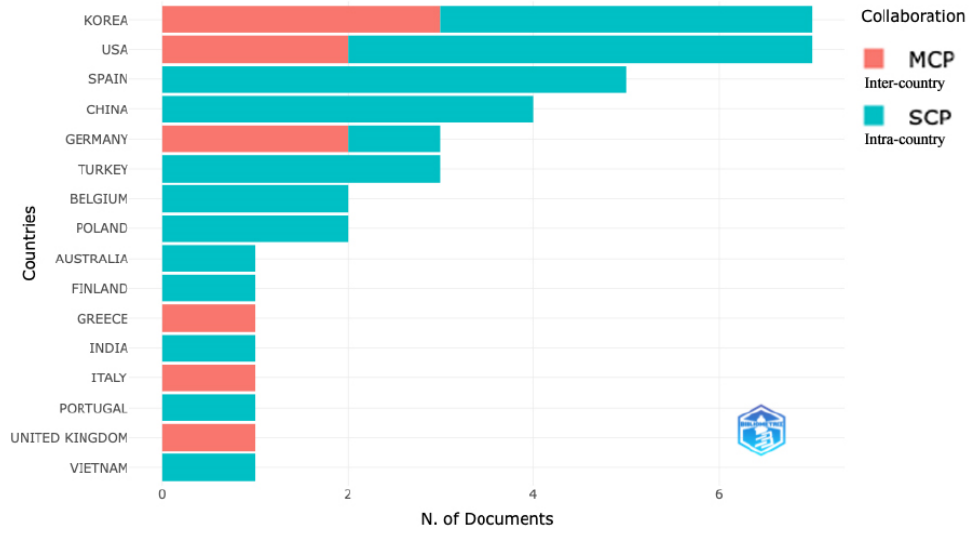
Figure 8. Collaboration index between countries.